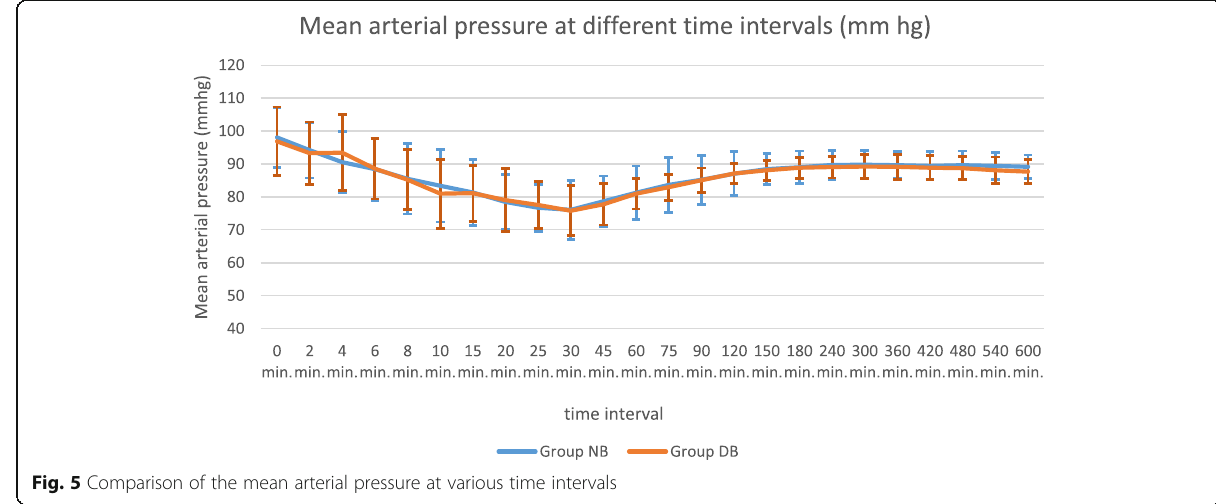
Fig. 5 Comparison of the mean arterial pressure at various time